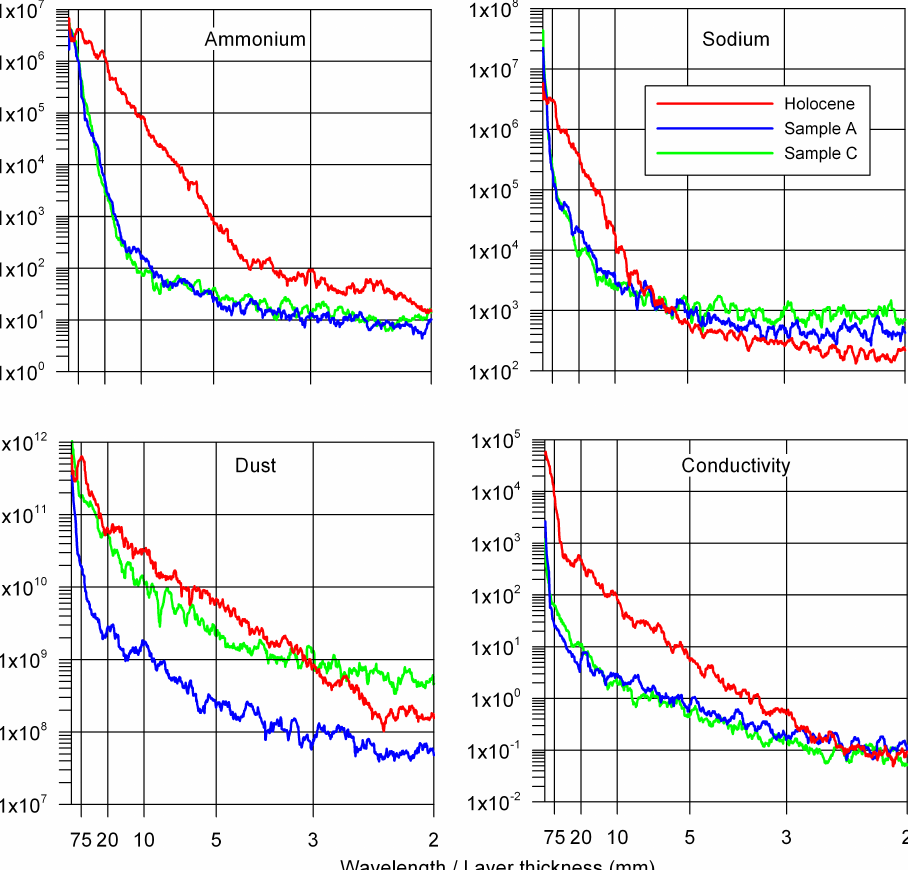
Fig. 4. Depth domain power density spectra comparing early Holocene, Eemian (sample “A”), and early glacial (sample “C”) NGRIP records. The spectra are obtained by FFT of 2.0m records in 1mm depth resolution. The “wavelength/layer thickness” is calculated as 2.0(m) times frequency. Holocene data are from Bigler et al. (2011). In the Holocene spectra a clear annual layer peak is visible at around 75mm, whereas the Eemian and glacial spectra show no clear indication of an annual peak. Data gaps are linearly interpolated.